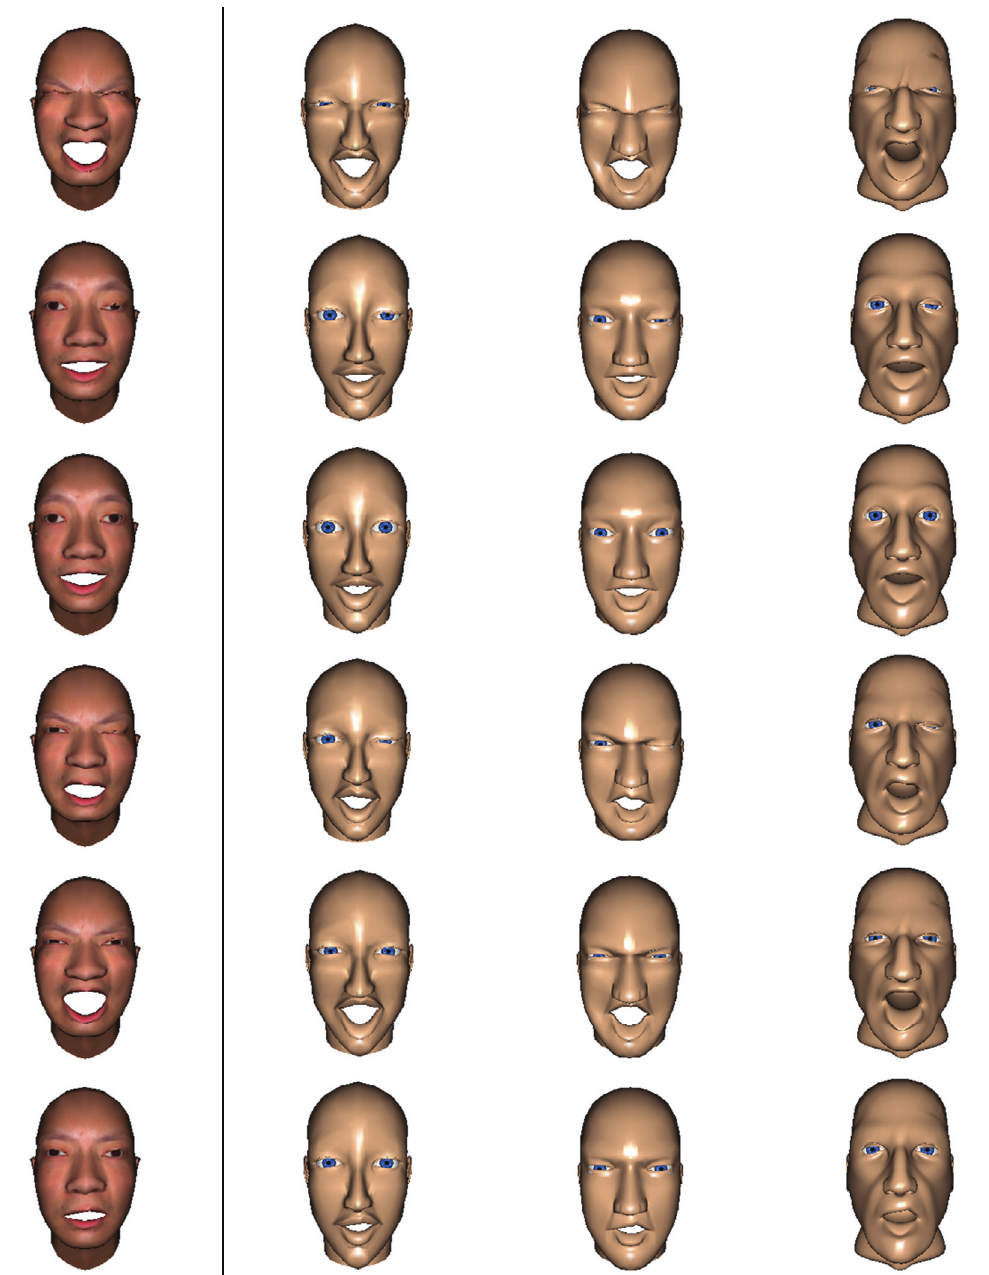
Figure 12: First column: the source model and expressions. Second column through the last column: the cloned expressions. Models have di ff erent shapes but expressions are well